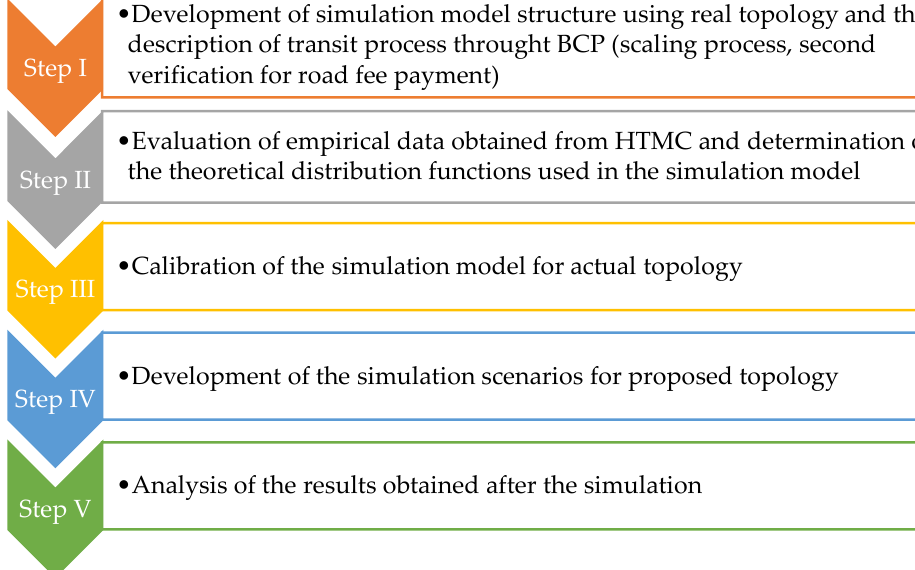
Figure 6. The simulation model development steps.